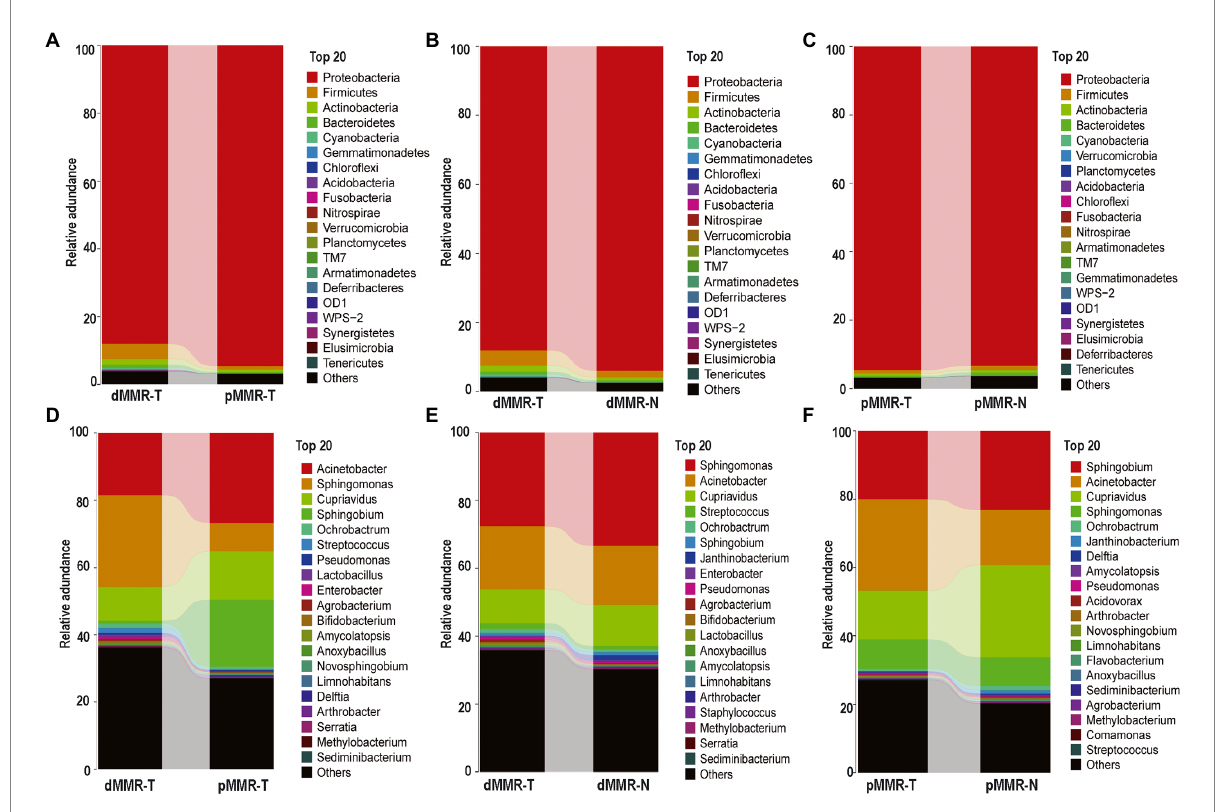
FIGURE 4 Taxonomic characteristics of the microbiota among the groups. Structure and abundance of flora at the phylum level between dMMR-T and pMMR-T group (A) , between dMMR-T and dMMR-N group (B) , and between pMMR-T and pMMR-N group (C) . dMMR, deficient DNA mismatch repair; pMMR, proficient DNA mismatch repair; dMMR-T, dMMR tumor tissue samples; pMMR-T, pMMR tumor tissue samples; dMMR-N, dMMR normal paracancerous samples; pMMR-N, pMMR normal paracancerous samples. And structure and abundance of flora at the genus level between dMMR-T and pMMR-T group (D) , between dMMRT and dMMR-N group (E) , and between pMMR-T and pMMR-N group (F)